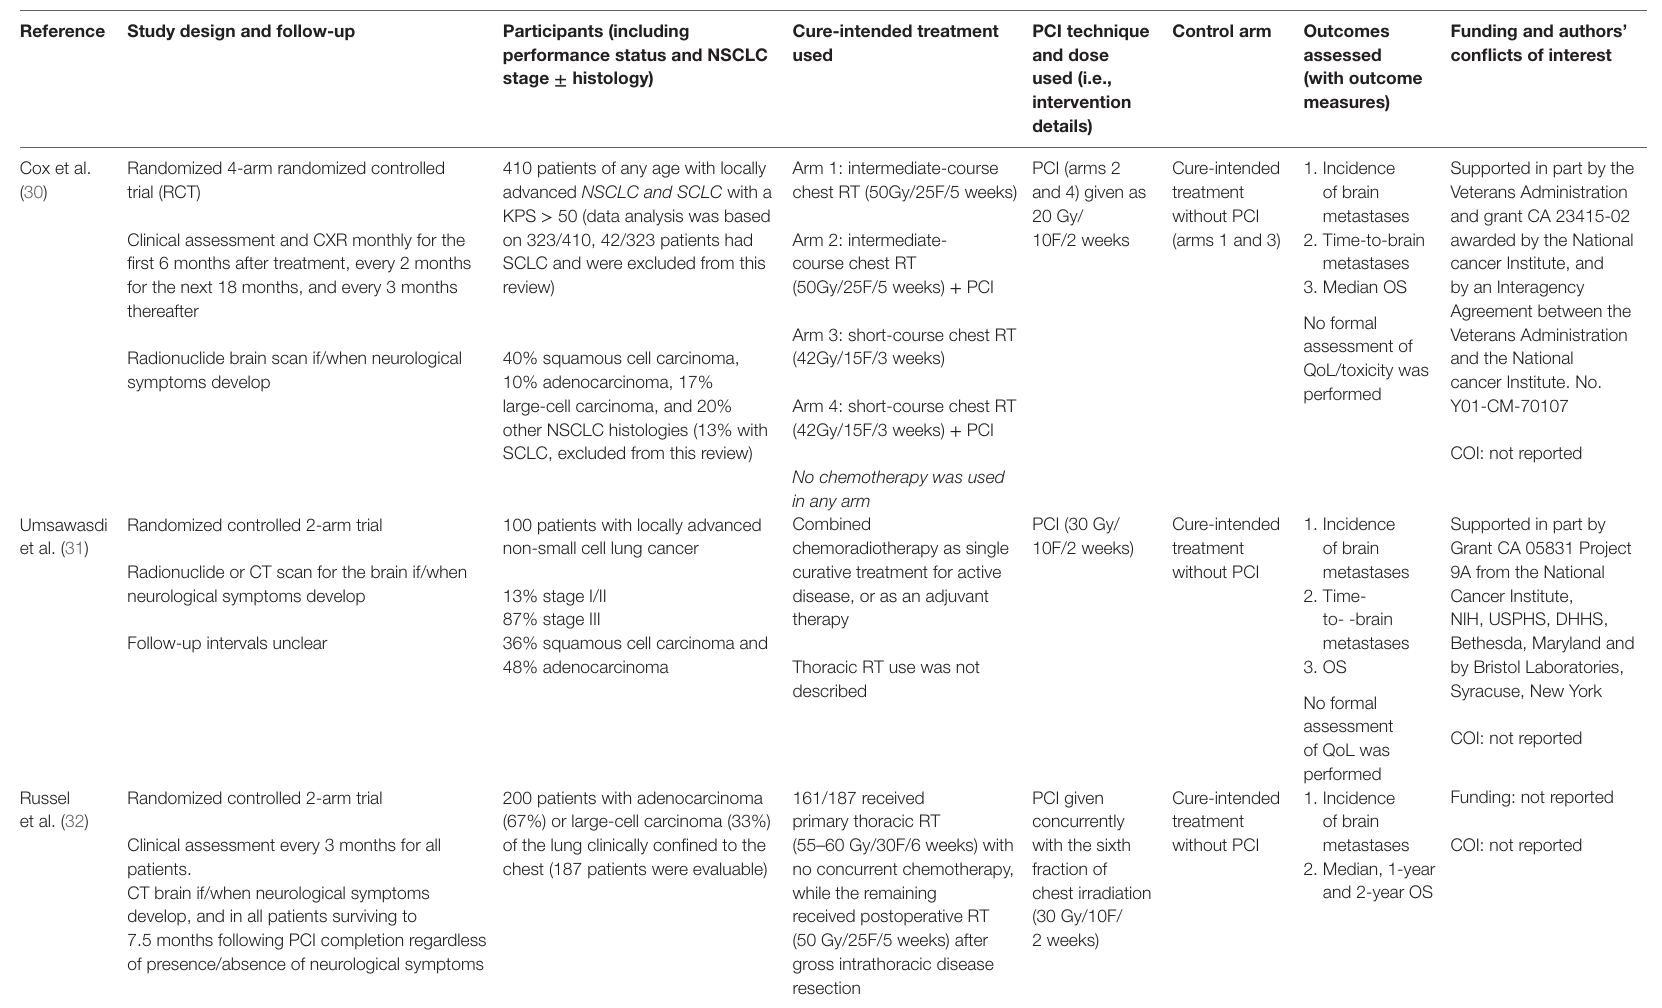
taBLe 1 | Characteristics of included